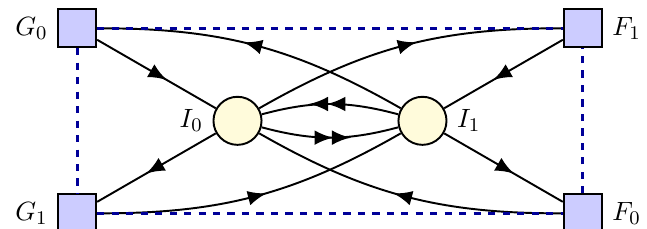
Figure 2 . Quiver representation for the theory discussed in the text, before taking the orientifold involution (described by a re(cid:13)ection with respect to a horizontal line through the quiver nodes, as described in section 3.4). We have indicated the matter between the (cid:13)avor branes by the blue dashed line, the actual matter content coupling to the quiver degrees of freedom will depend on choices of (cid:13)ux away from the singularity.